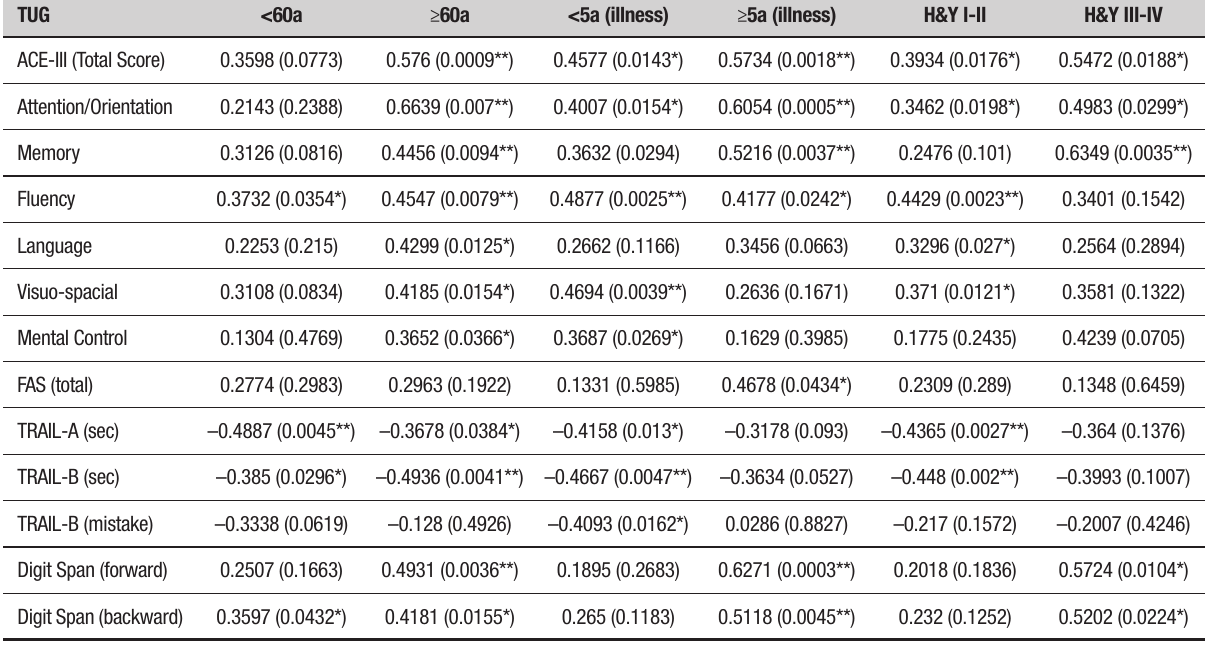
Table 4. Subgroup. Timed up Go